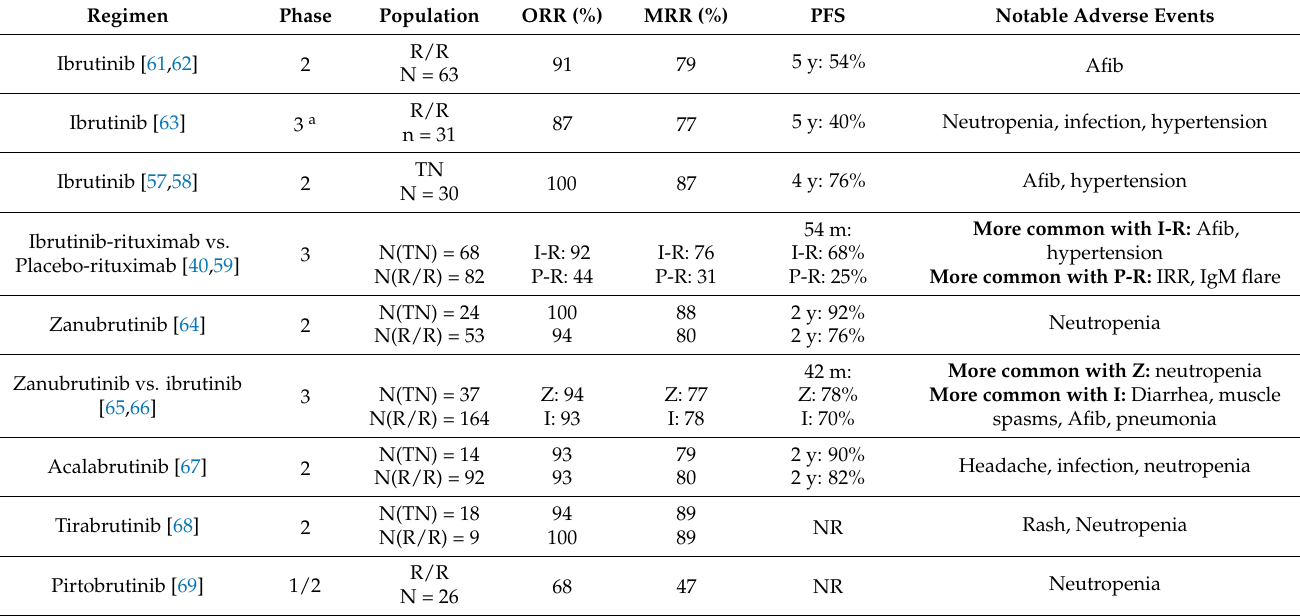
Table 3. Notable clinical trials evaluating Bruton tyrosine kinase inhibitors in Waldenström